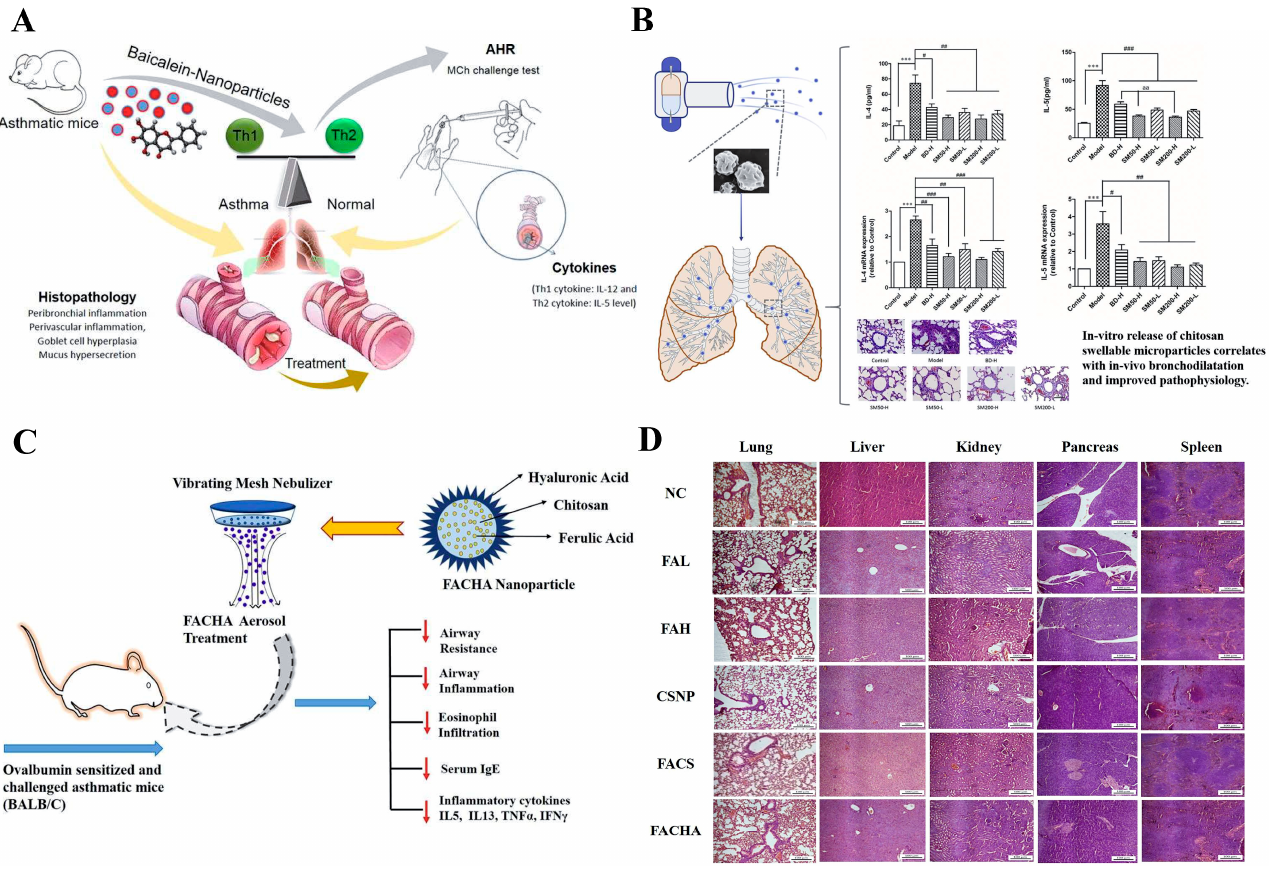
Figure 3. ( A ) The application of chitosan loaded baicalein nanoparticles (L-B-NPs) for asthma treat- ment. Reproduced with permission from [31], © 2022 The Author(s). Published by Elsevier B.V. on behalf of King Saud University. ( B ) The chitosan-based swellable microparticles for loading budesonide reduced the levels of IL-4 and IL-5 in-vivo and improved pathophysiology. Reproduced with permission from Statistics: *** p <0.001 vs control group; ### p < 0.001, ## p < 0.01, # p < 0.05 vs.